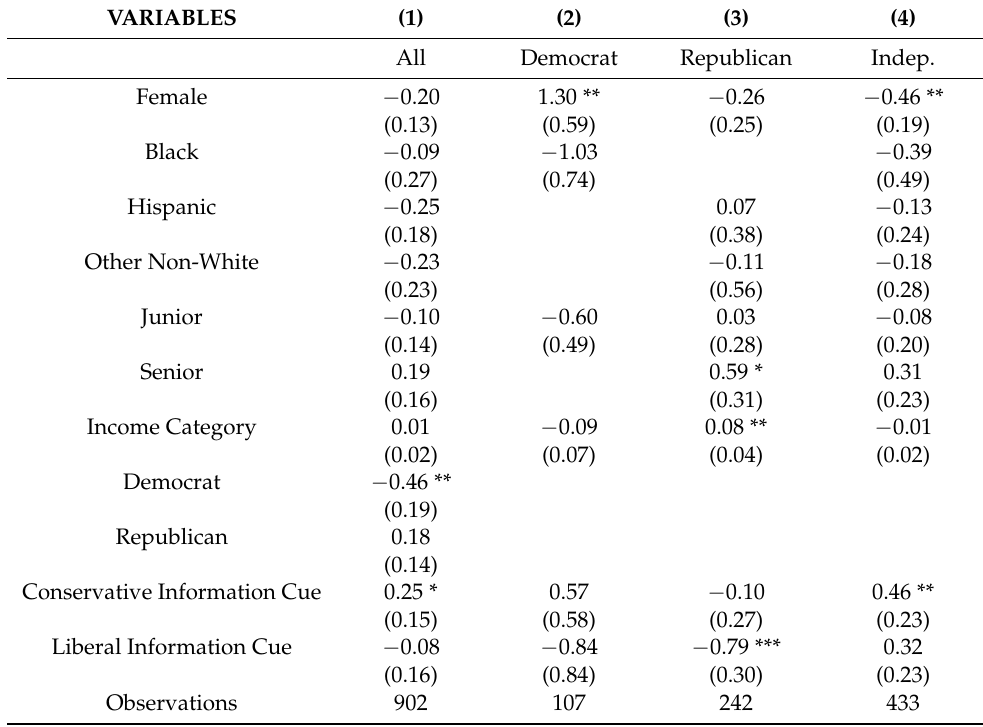
Table 9. Information cues and attitudes towards gun control laws. Probits: dependent variable is equal to one for those that strongly agree with the statement that “gun control laws in most states are too strict.” VARIABLES (1) All Democrat Republican Indep.